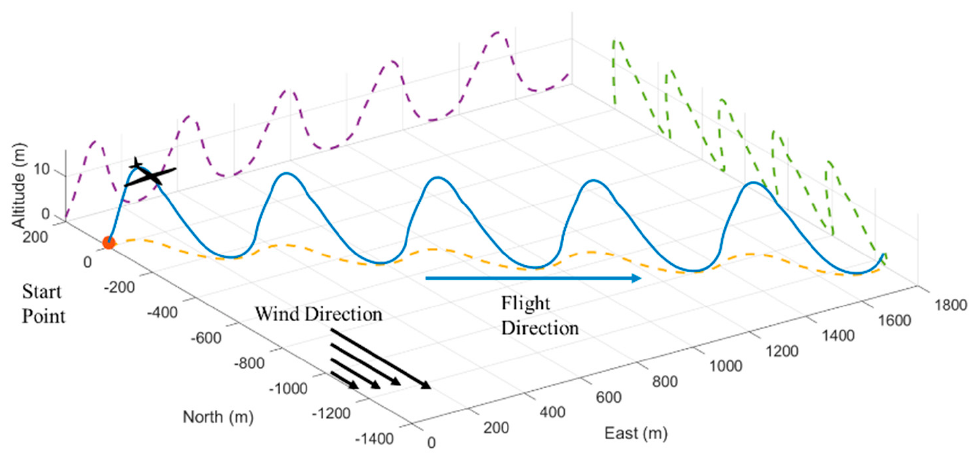
Figure 10. The dynamic soaring trajectory. The 3D trajectory is in the color blue, others are the trajectory projection in three directions.